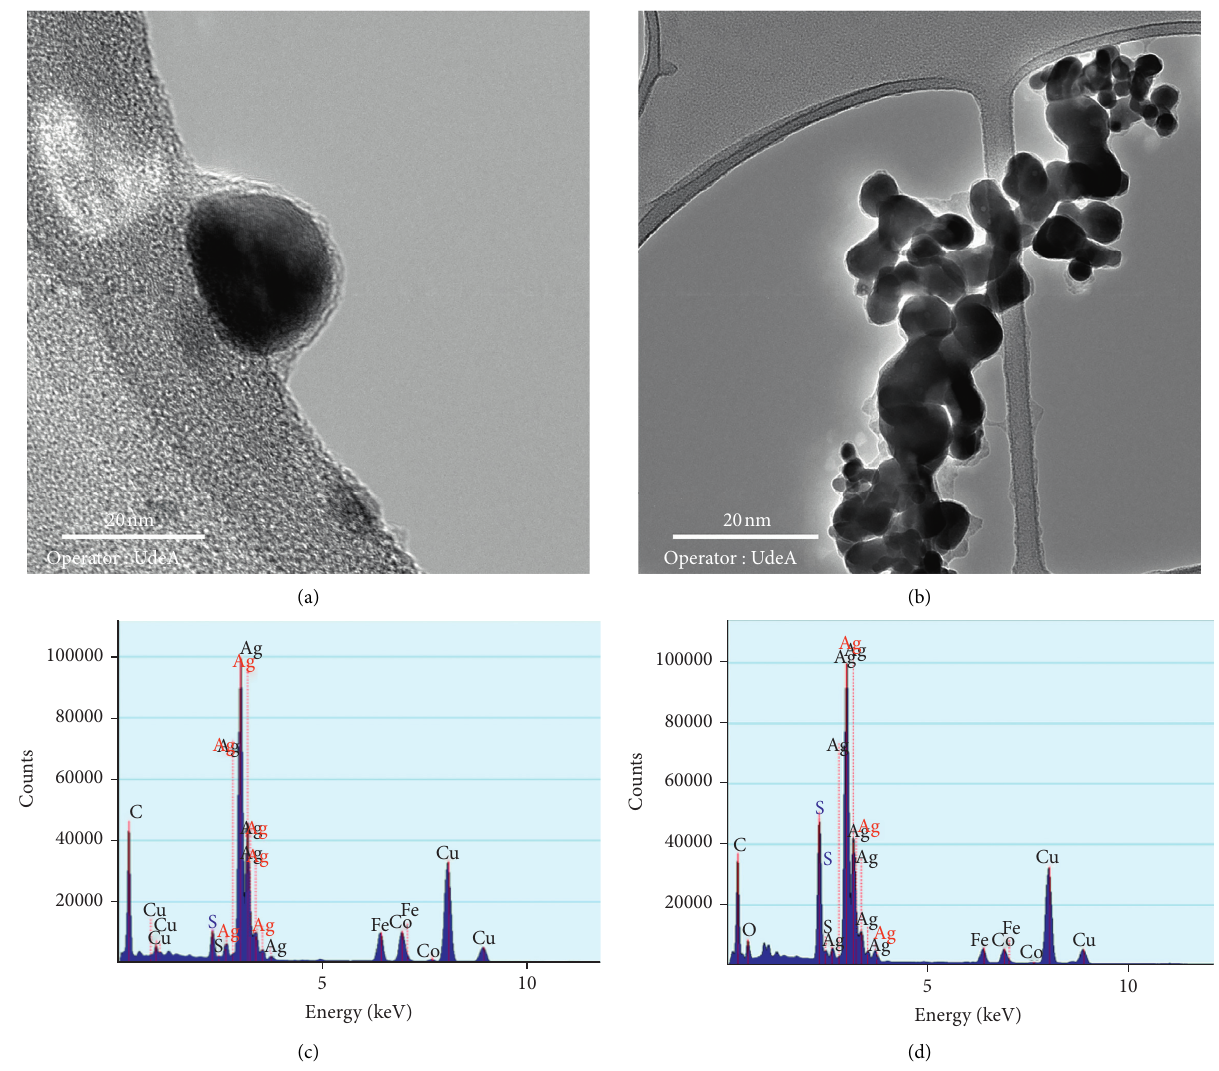
Figure 5: TEM photomicrography of (a) G-AgNPs-2 and (b) S-AgNPs-2. Energy dispersive spectroscopy (EDS) of silver nanoparticles (c) G-AgNPs and (d) S-AgNPs.